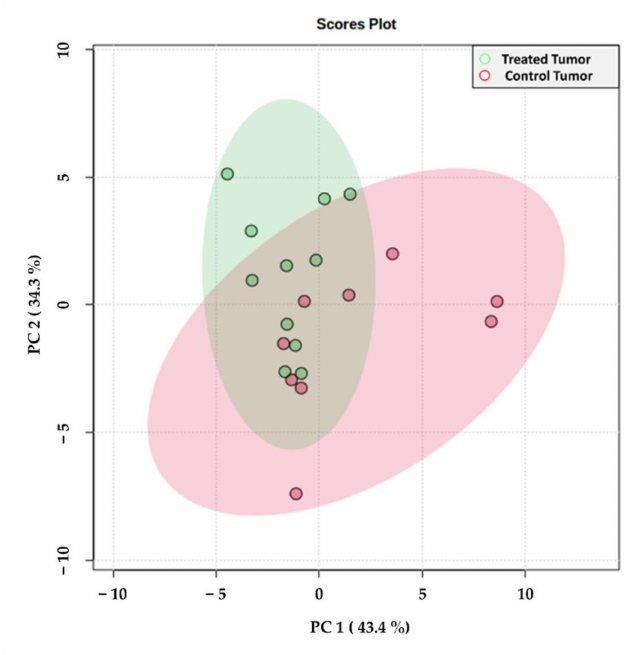
Figure 2. Principal component analysis score plot of the tumor regions from treated (green) and control (red) samples. Each spot represents an individual tissue section including all samples and their technical replicates (at least two for each sample). Colored circles represent 95% confidence intervals. Corresponding loading plot can be found in Figure